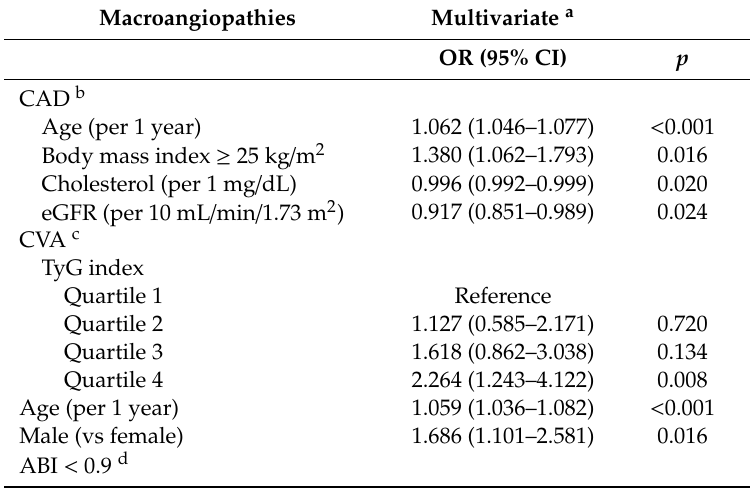
Table 3. Determinants of Macroangiopathies Using Forwad Binary Logistic Regression